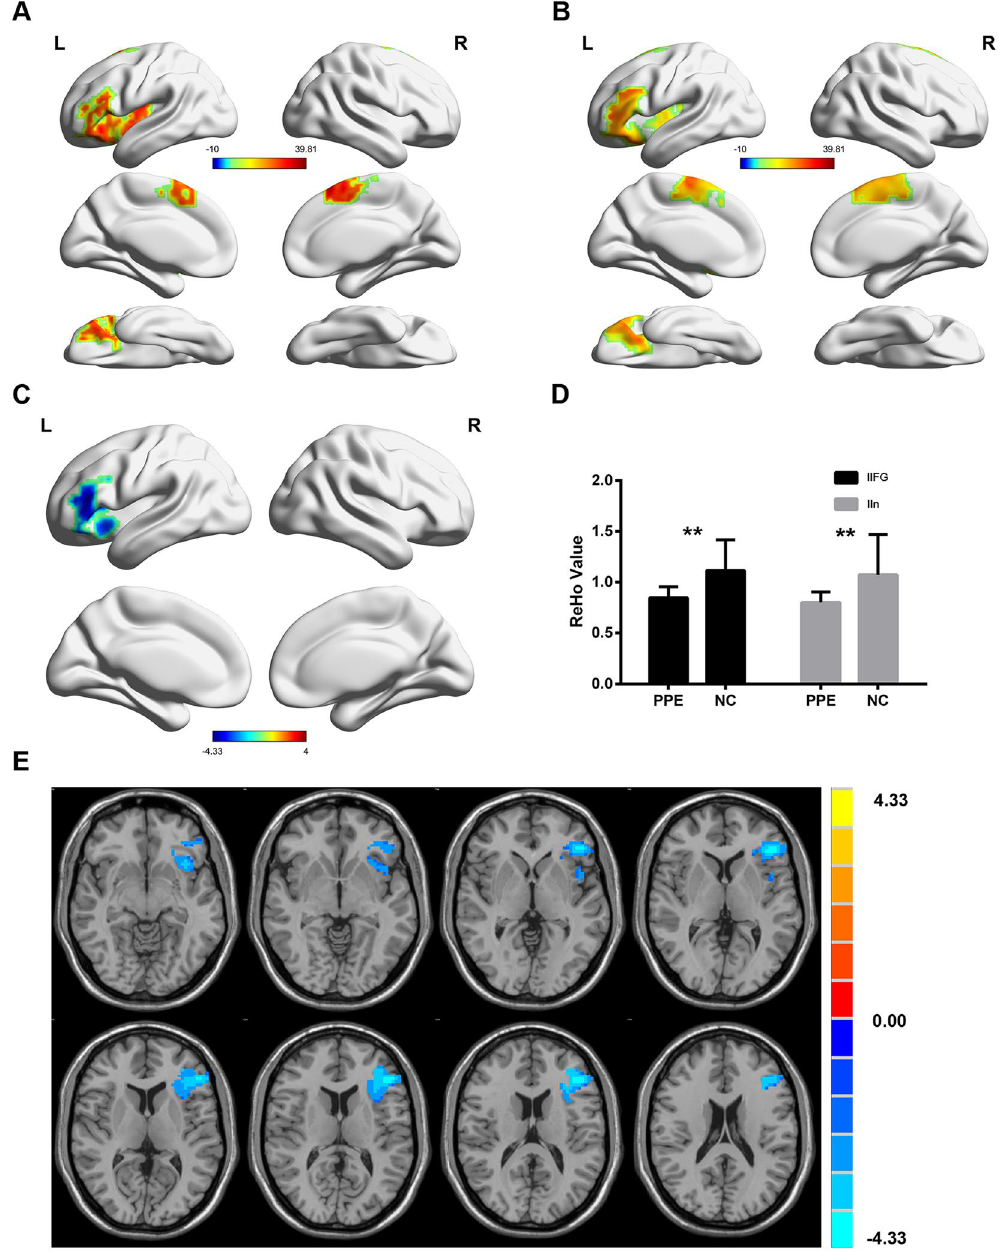
Figure 2. Resting brain spontaneous activity. The mean rs fMRI activation maps (ReHo) of ( A ) PE patients and ( B ) the NC group. ( C,E ) t-test results of independent samples indicating the voxels in which the PE patients demonstrated significantly decreased activation compared to the NC group (T map threshold at p < 0.05, AlphaSim corrected). ( D ) The ReHo value in the left inferior frontal gyrus and left insula. lIFG: left inferior frontal gyrus; lIn: left